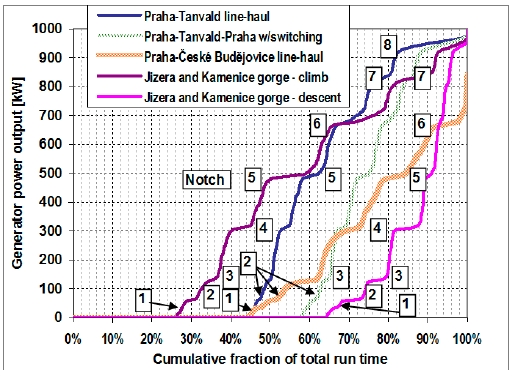
Figure 9. Cumulative distribution of locomotive generator output for the Praha–Tanvald line per schedule and with rides to / from depot and shunting cars at endpoints, and for major incline sections of this line along river gorges, and for Praha– ˇCesk é Budˇejovice